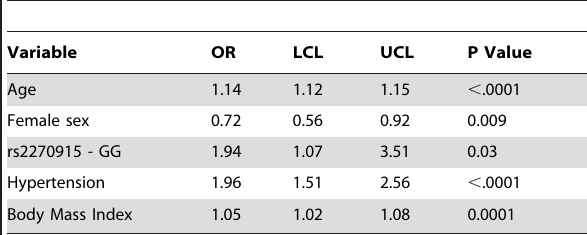
Table 3. Multivariable Logistic Regression Model for Diastolic Dysfunction (AUC=0.828).